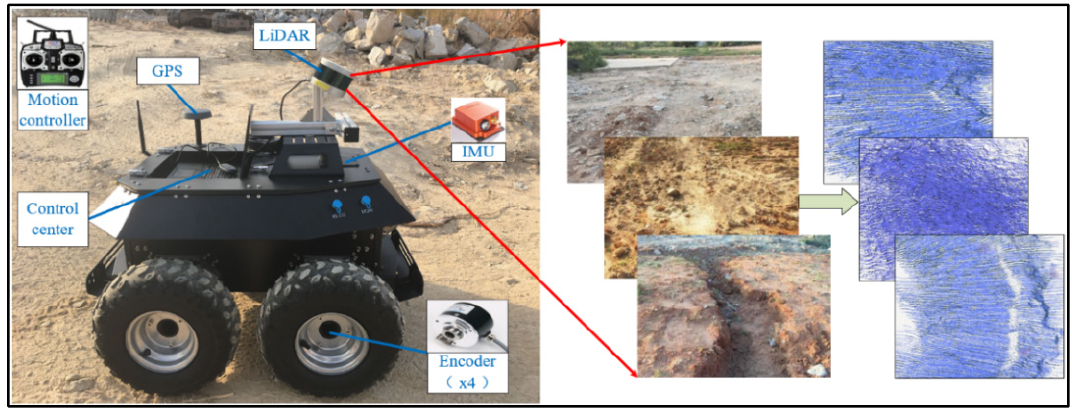
Figure 17. Obstacle recognition result of the 3D mapping dataset.